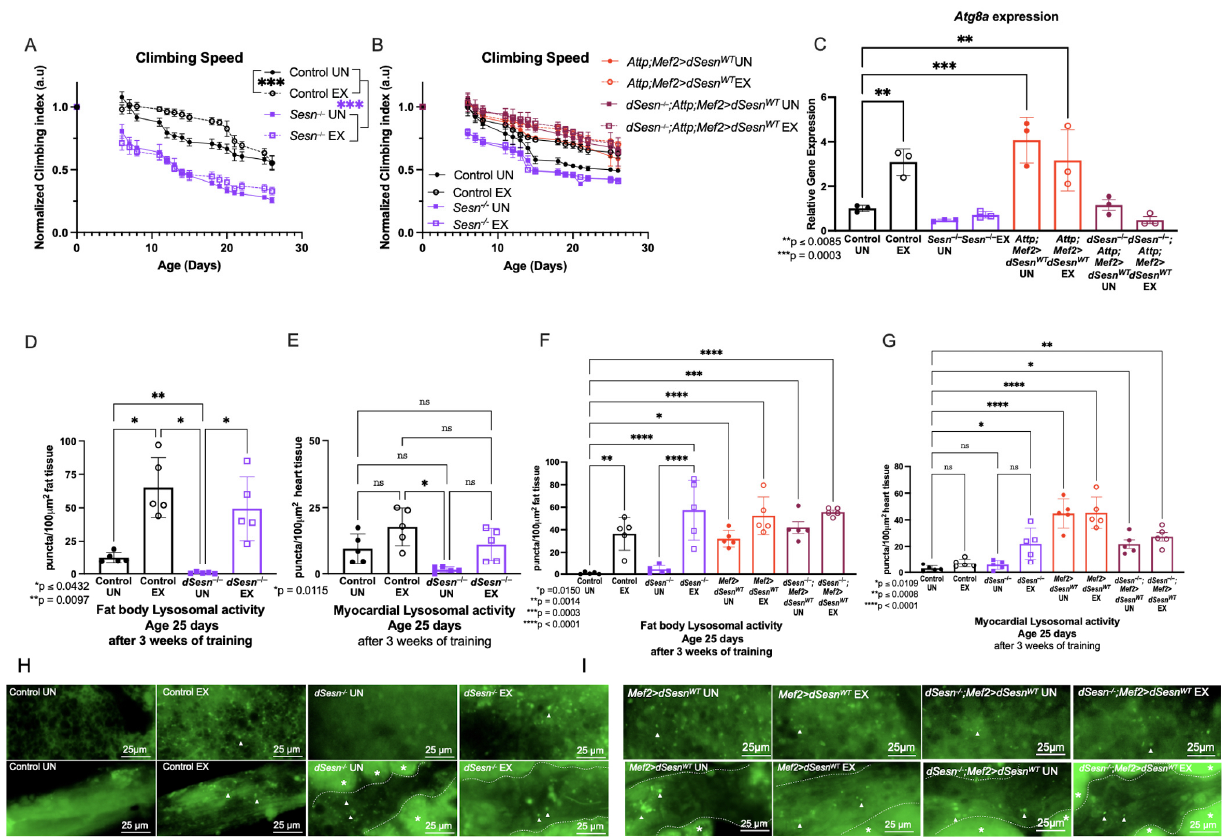
Figure 1. Sestrin drives exercise adaptations to climbing speed and lysosomal activity. ( A ) dSesn − / − flies have lower climbing speed than control flies whether exercised or not (2-way ANOVA, genotype effect, p ≤ 0.019 beginning at day 4). Exercise increases climbing speed in control flies (2-way ANOVA, exercise effect, p ≤ 0.0465, days 8–22). ( B ) Flies expressing dSesn in muscles in either a wild-type or dSesn null background ( Attp;Mef2 > dSesn WT , dSesn − / − ; Attp;Mef2>dSesn WT , respectively) have high climbing speed whether exercised or not (2-way ANOVA, genotype effect, p ≥ 0.1032). Climbing speed experiments performed in triplicate, n ≥ 100 flies. ( C ) Atg8 gene expression is elevated in exercised background controls (ANOVA, p = 0.0085) and Attp;Mef2 > dSesn WT flies, whether exercised or not (ANOVA, p = 0.0003, EX p = 0.0064, UN). Data are presented as ∆∆ CT normalized to Atg8a gene expression in unexercised Control flies. N = 20 flies per cDNA extraction, performed in triplicate. ( D ) Exercise increases fat body Lysotracker in control flies (ANOVA, p = 0.0284). | Unexercised dSesn − / − flies have low fat body Lysotracker (ANOVA, p = 0.0097) but staining increases with exercise (ANOVA, p = 0.0432). ( E ) Myocardial Lysotracker staining is low in unexercised dSesn − / − flies (ANOVA, p = 0.0115). All other genotypes have similar myocardial Lysotracker staining. ( F ) Exercised dSesn − / − ; Attp;Mef2 > dSesn WT flies have high fat body Lysotracker whether exercised or not (ANOVA, p ≤ 0.0014). ( G ) Myocardial Lysotracker staining is high in both Attp;Mef2 > dSesn WT and dSesn − / − ; Attp;Mef2 > dSesn WT flies whether exercised or not (ANOVA, p ≤ 0.0109). ( H ) Representative 63 × images of Lysotracker staining in fat body (upper panels) and myocardium (lower panels) from control and dSesn − / − flies, quantified in ( D , E ). ( I ) Representative 63 × images of Lysotracker staining in fat body (upper panels) and myocardium (lower panels) from Attp;Mef2 > dSesn WT and dSesn − / − ; Attp;Mef2 > dSesn WT flies, quantified in ( F , G ). Lysotracker staining n = 5, performed in duplicate or triplicate. Dotted lines in myocardial images delineate heart tissue. White triangles point to example regions of puncta. White asterisks indicate pericardial cells. Brackets represent pairwise post-hoc comparisons from ANOVA. ns or lack of brackets indicates no significant difference. Error bars depict ± SD. EX = cohort after 3 weeks of ramped, daily endurance training. UN = control unexercised flies exposed to identical training environment without